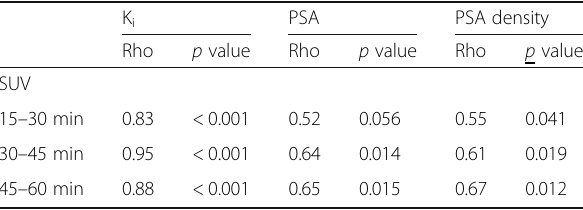
Spearman correlation rho with corresponding p value. n = 14, the most avid lesion per subject